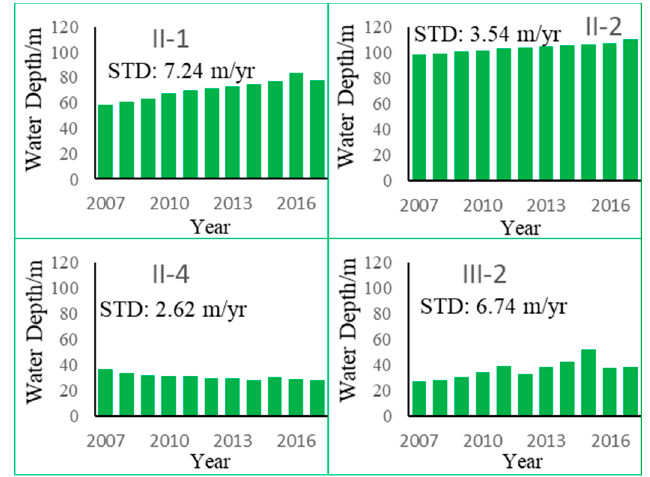
Figure 10. Groundwater depth of confined aquifers in different hydrogeological zones. STD: interannual standard deviation of confined water depth. The II-1, II-2, II-4, and III-2 subgraphs show the average groundwater depth of the unconfined aquifer in the II-1, II-2, II-4, and III-2 hydrogeological zones defined in Figure 2a.